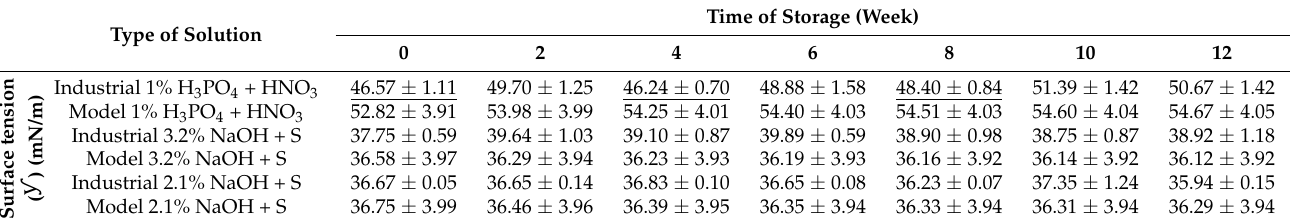
Table 3. Significant differences between empirical data and model results (Tukey’s HSD test, α = 0.05). Type of